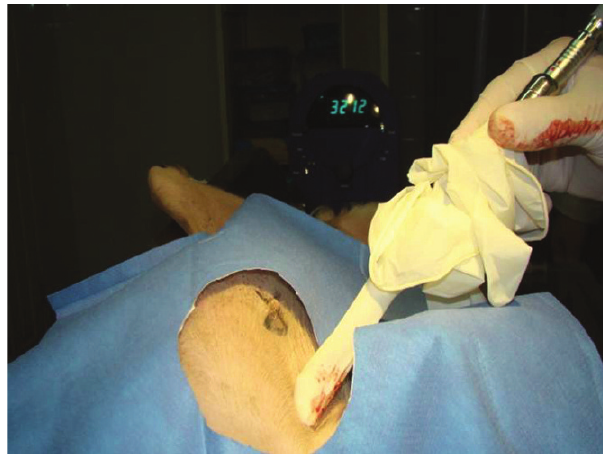
Figure 2 - Performing axillary mapping using a gamma probe to identify the location of the projection of the sentinel node in the